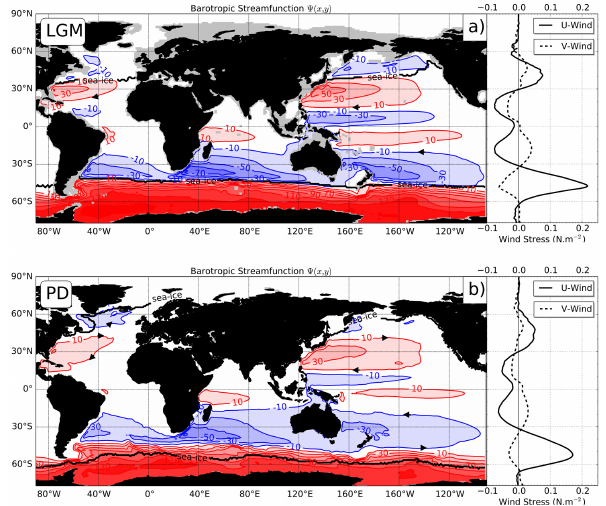
Figure 1. Barotropic streamfunctions for (a) the LGM simulation and (b) the PD simulation. The contour interval for the circulation is 20Sv. Red contours indicate clockwise circulations and blue con- tours are for anti-clockwise circulations. The thick black line cor- responds to the maximum sea-ice extent. Left diagram shows the time and zonally averaged zonal wind stress (U Wind) and merid- ional wind stress (V Wind) over the ocean